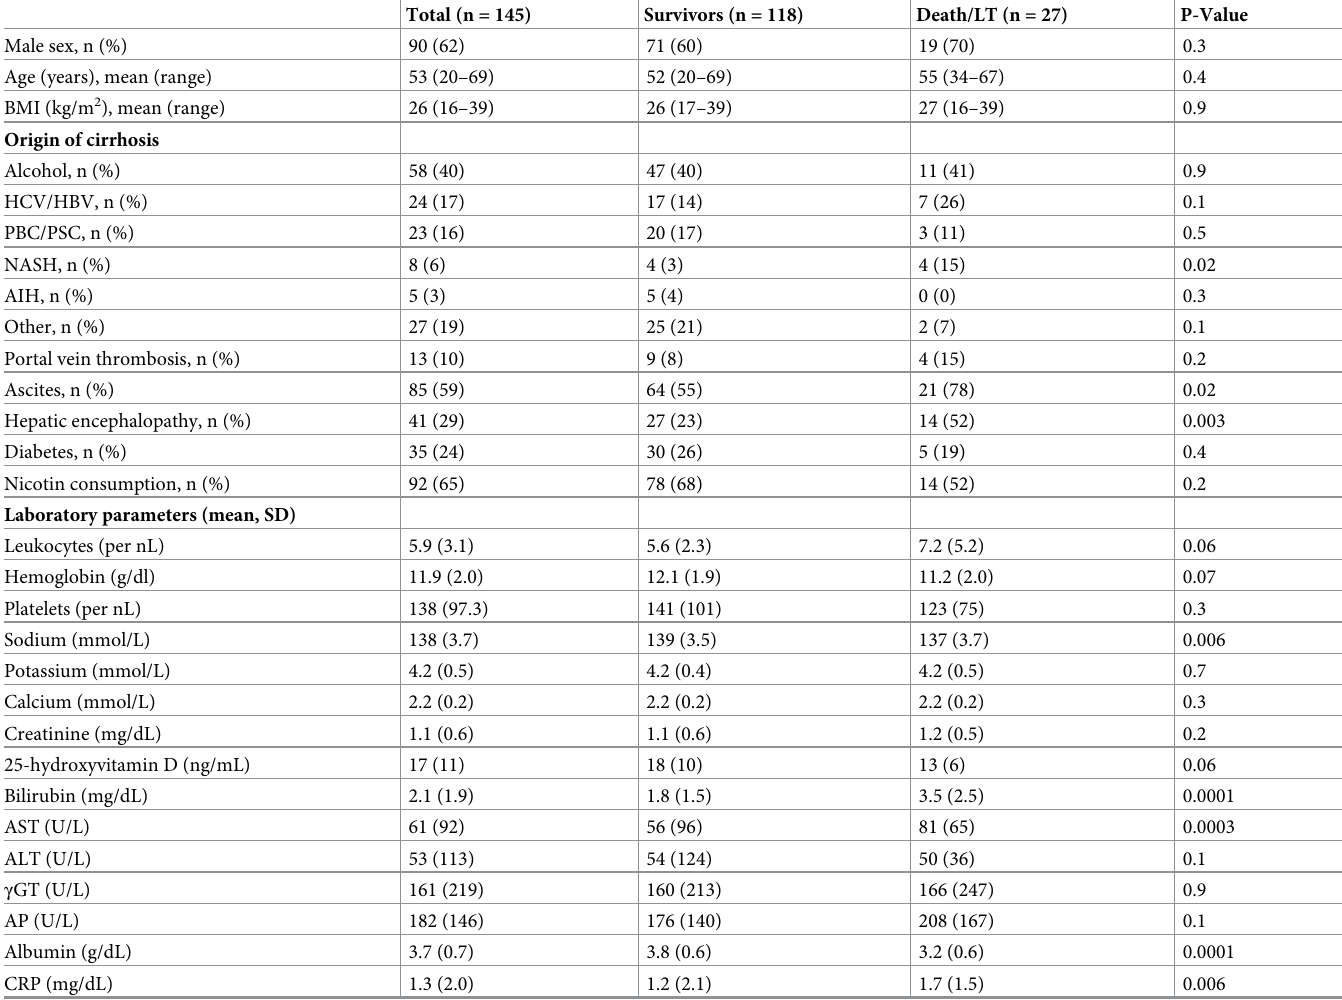
Table 1. Baseline and demographic